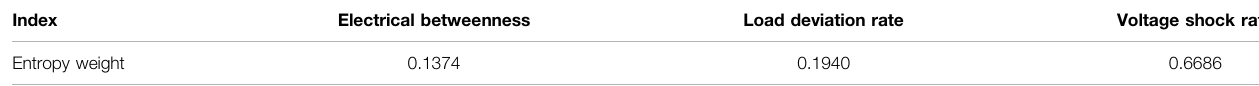
TABLE 1 | Entropy weight distribution.